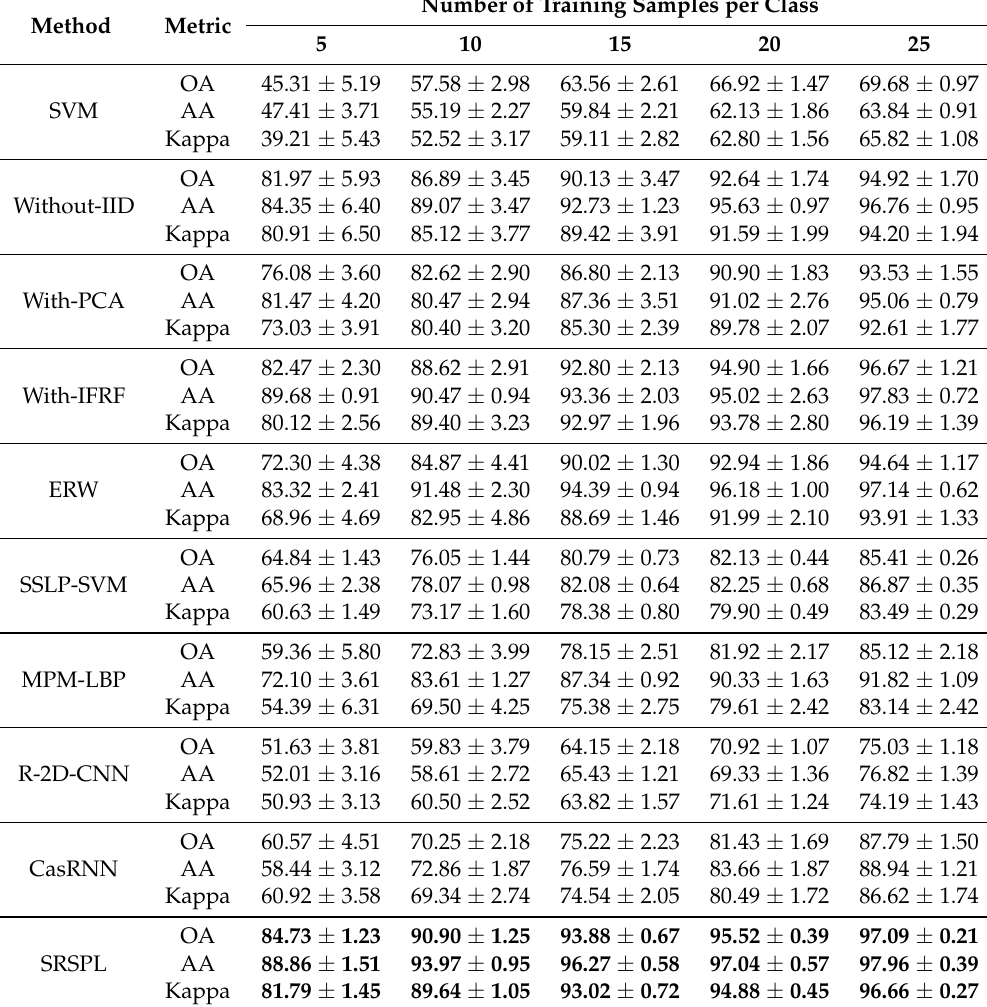
Table 1. Classification performance of different methods performed on the Indian Pines data set with 5–25 training samples per class. Without-IID is the proposed method without the IID Step. With-PCA and With-IFRF denote the proposed method using different methods for feature extraction. (SVM, support vector machine; ERW, extended random walker; SSLP-SVM, spatial-spectral label propagation based on SVM; MPM-LBP, the maximizer of the posterior marginal by loopy belief propagation; R-2D-CNN, recurrent 2D convolutional neural network; CasRNN, cascaded recurrent neural network; SRSPL, sample pseudo-labeling method based on sparse representation. Three common metrics: overall accuracy (OA), average accuracy (AA), Kappa coefficient. The bold values indicate the greatest accuracy among the methods in each